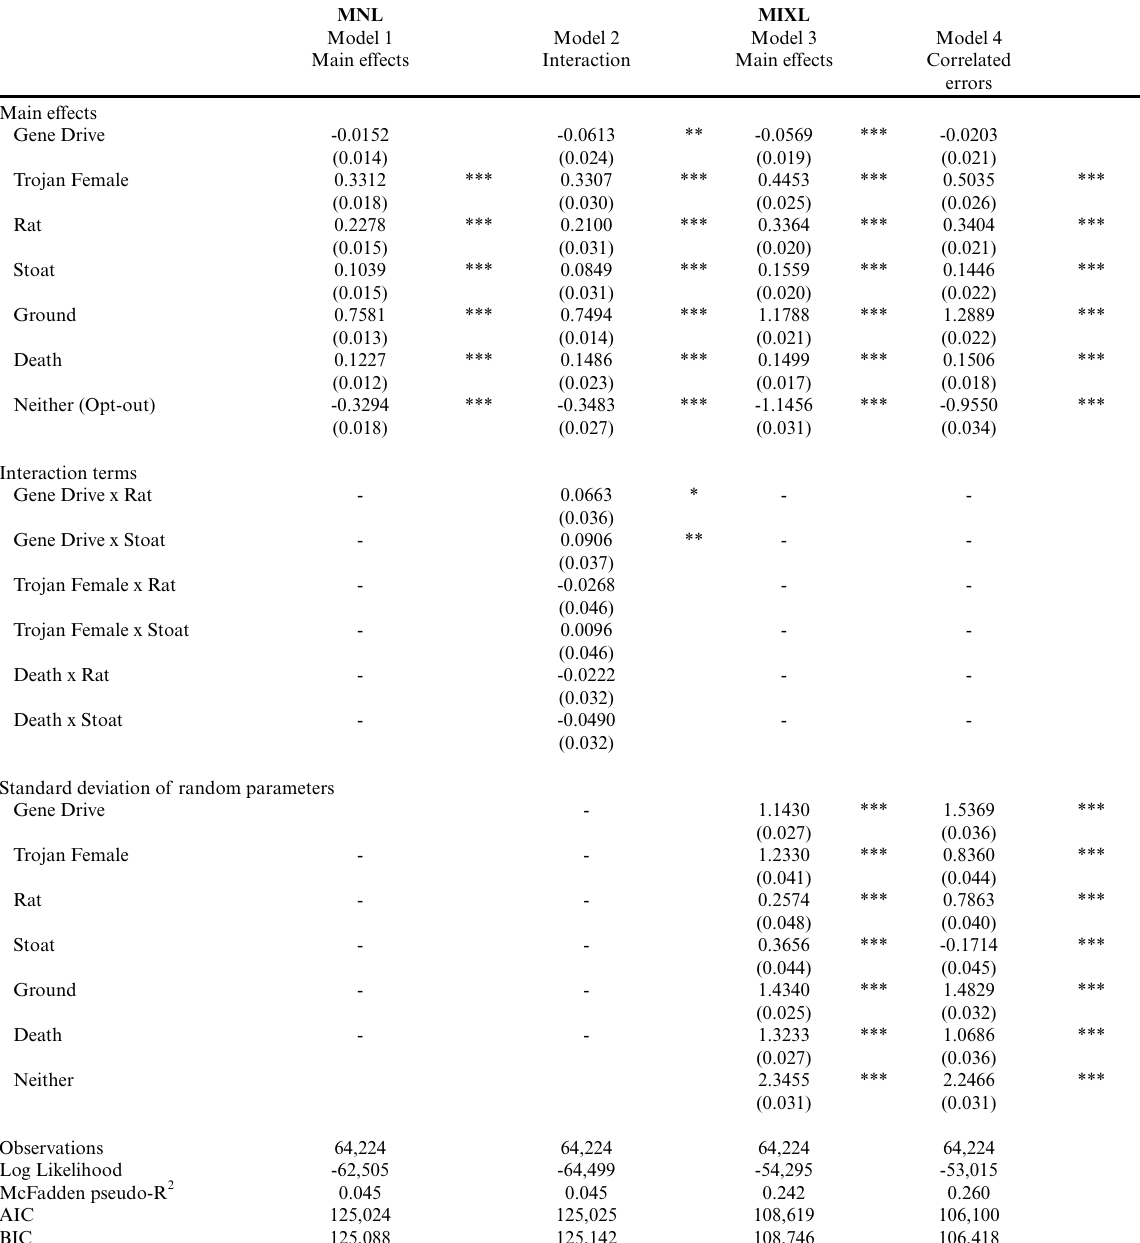
Table 4 . Estimated choice models without demographics and psychometrics. Coefficients are log odds ratios with standard errors shown in parentheses. All variables are dummy-coded. Random parameters are assumed to have the normal distribution.